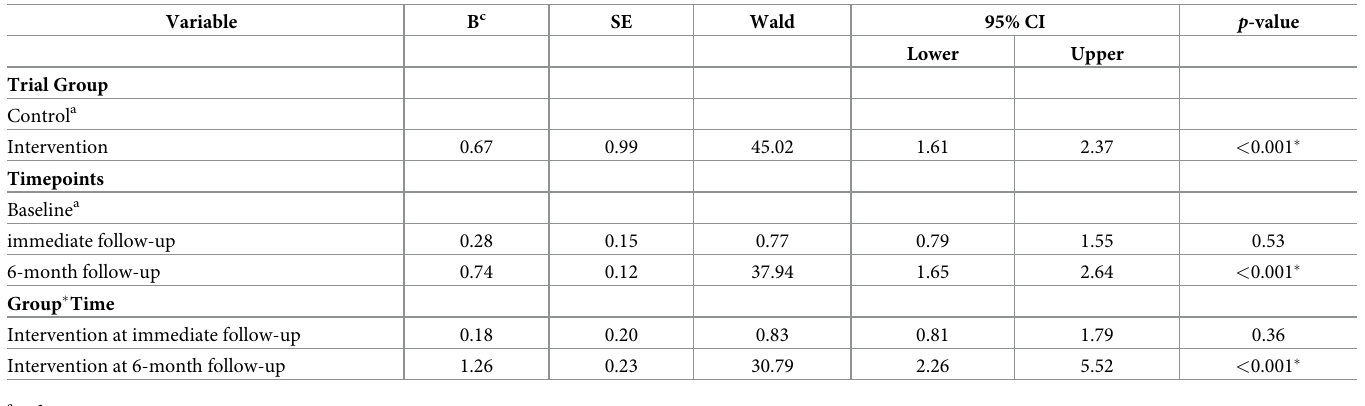
Table 4. Effectiveness of HEBI on Knowledge between intervention and control